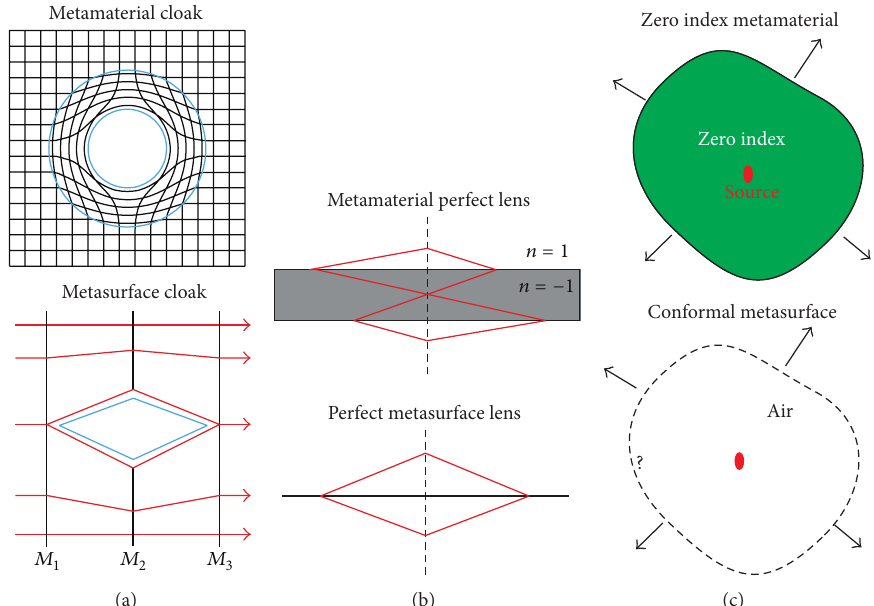
Figure 1: Comparison of metamaterials with metasurfaces. (a) Metasurface cloak. (b) Perfect metasurface lens. (c) Conformal metasurface versus traditional zero index metamaterial. Figures are reproduced from